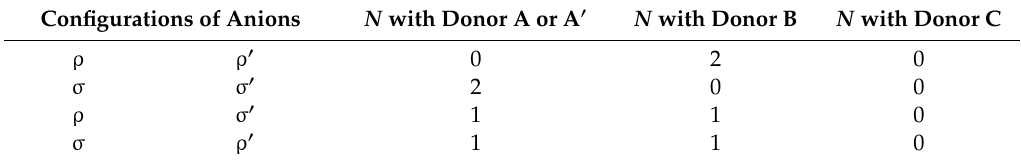
Figure 7. Interactions between bis(ethylenedithio)tetraselenafulvalene (BETS) and each disordered conformer (( a ) ρ and ( b ) σ ) of isethionate in 3 , where dotted lines indicate S ··· O contacts shorter than the van der Waals distance (3.37 Å). Table 2. Numbers ( N ) of effective short S···O contacts (<3.1 Å ) of 3 for four possible anion arrangements.